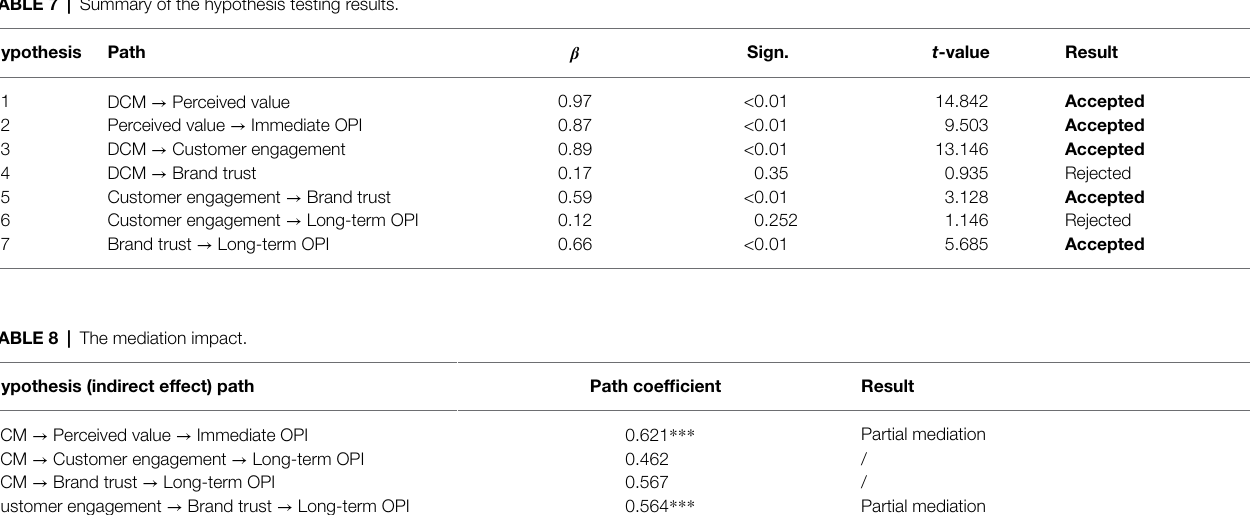
TABLE 7 | Summary of the hypothesis testing results.